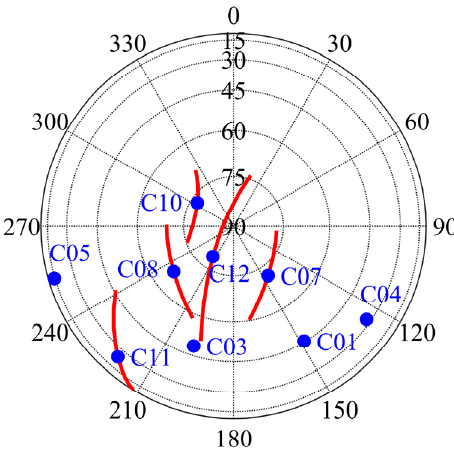
Figure 14. The azimuth and elevation angle data of the visible BeiDou Navigation Satellite System (BDS) satellites from 3:00 to 5:00 on 18 July 2014 in coordinated universal time (UTC).